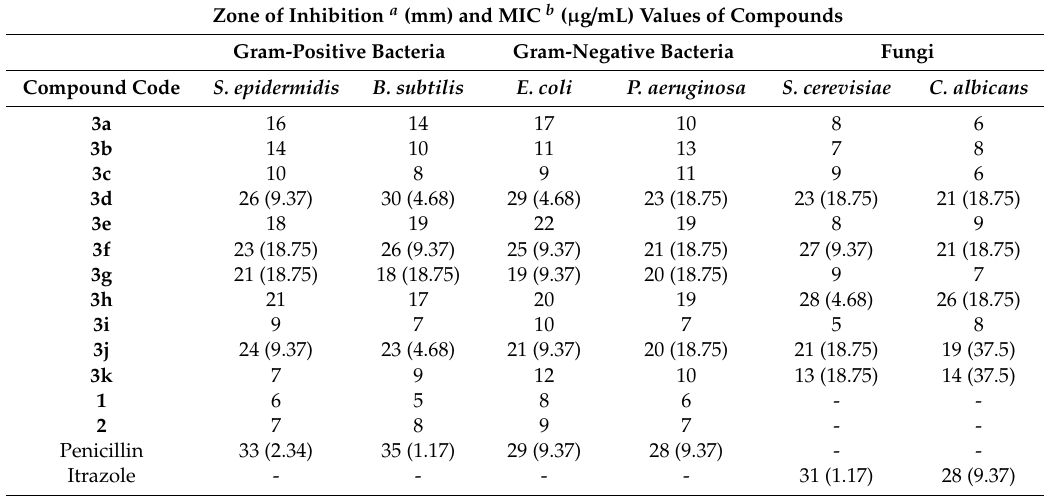
Table 2. Antimicrobial screening of the synthesized 2-hydroxy-3-hydroxy dithiocarbamate derivatives ( 3a – k ). Zone of Inhibition a (mm) and MIC b ( µ g / mL) Values of Compounds Gram-Positive Bacteria Gram-Negative Bacteria Fungi Compound Code